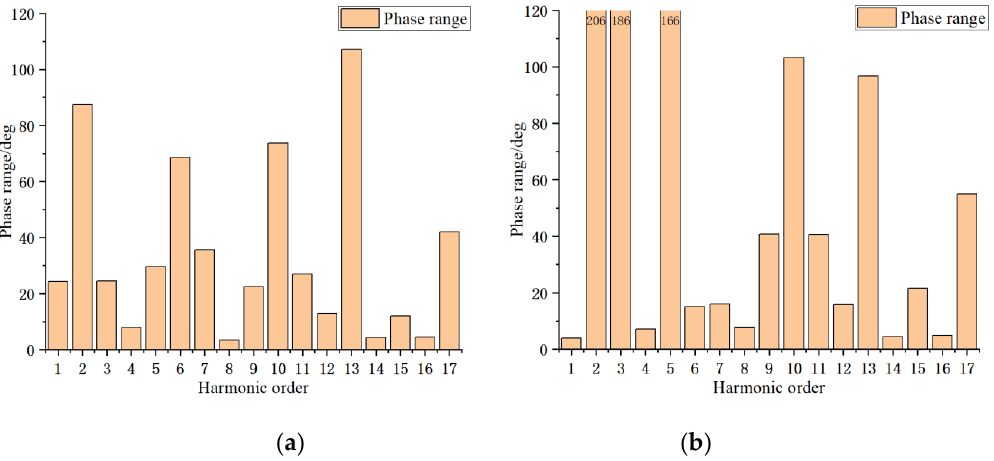
Figure 6. Harmonic amplitude-order diagram of joint module angle errors: ( a ) joint module a; ( b ) joint module b.